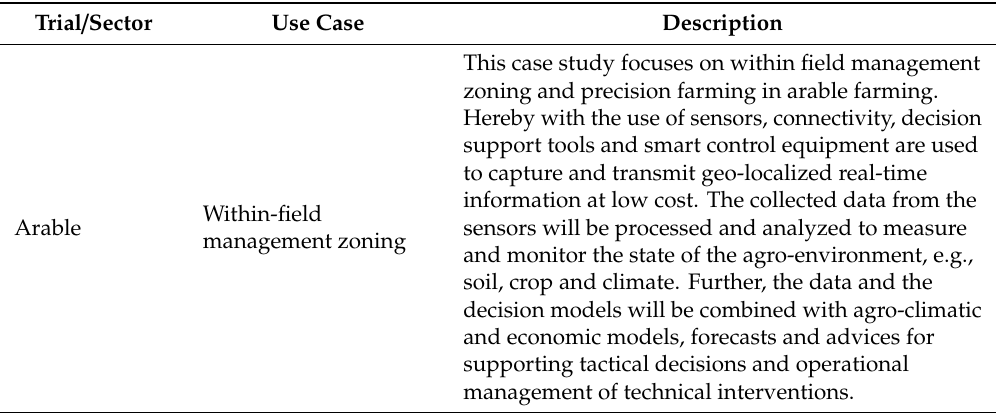
Table 1. Overview of the adopted use